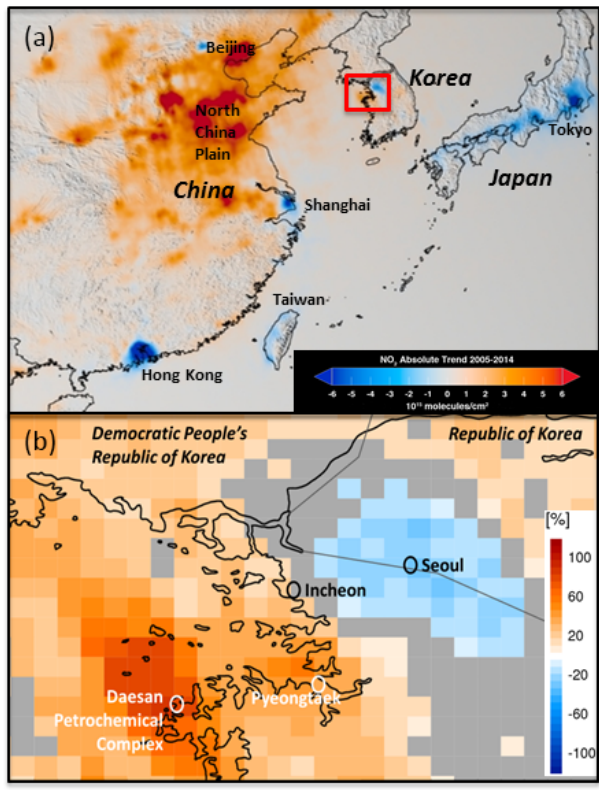
Figure 2. The world shows intriguing spatial heterogeneity and changes in air pollution from 2005 to 2014 in OMI NO 2 (Duncan et al., 2016), a common pollutant from power plants and automo- biles. (Top panel) emission controls were implemented before 2010 in Japan, Taiwan, Beijing, Shanghai and Hong Kong, which led to decreasing trends in these regions and cities. Rapid growth until about 2011 in China’s manufacturing heartland, the North China Plain, led to increases. Since 2011, levels there have begun to de- crease following the gradual introduction of emission controls. The area outlined in red, the Seoul metropolitan area, is expanded in the bottom panel. (Bottom panel) ongoing retrieval algorithm work al- lows for unprecedented detail, including to sub-urban scales. The Seoul metropolitan area illustrates complex changes in OMI NO 2 from 2005 to 2014, which are likely associated with pollution emis- sion controls in Seoul (decreases) and ambitious infrastructure de- velopment (increases) of the Incheon Free Economic Zone, Incheon International Airport, and the Daesan petrochemical